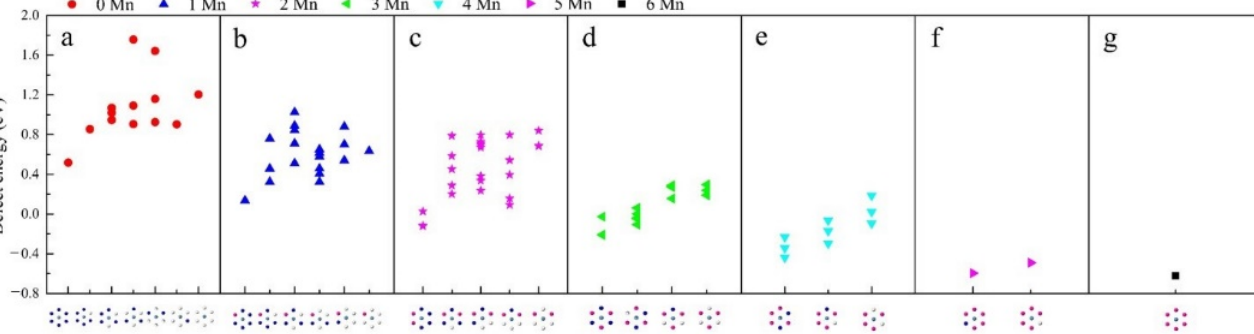
Figure 6. The defect energy of the Li/Ni anti-site with different local coordination environments. From ( a – g ), the Mn number of six local TM ions increases in turn. The schematics at the bottom represent the local coordination ion environment for the anti-site Li-ion in the TM layer. For one schematic of the bottom, the different points of the longitudinal axis represent the defect energy of various arrangements under the corresponding number of Ni, Mn, and Co.